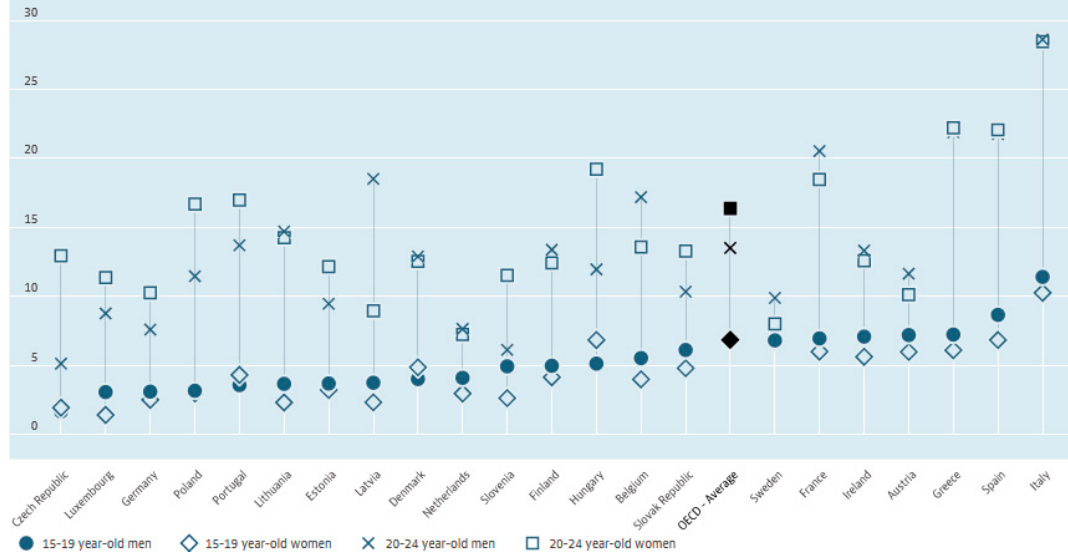
Figure 2. Youth not in employment, education, or training in 2019 by age group and gender. Source: OECD (2021a).